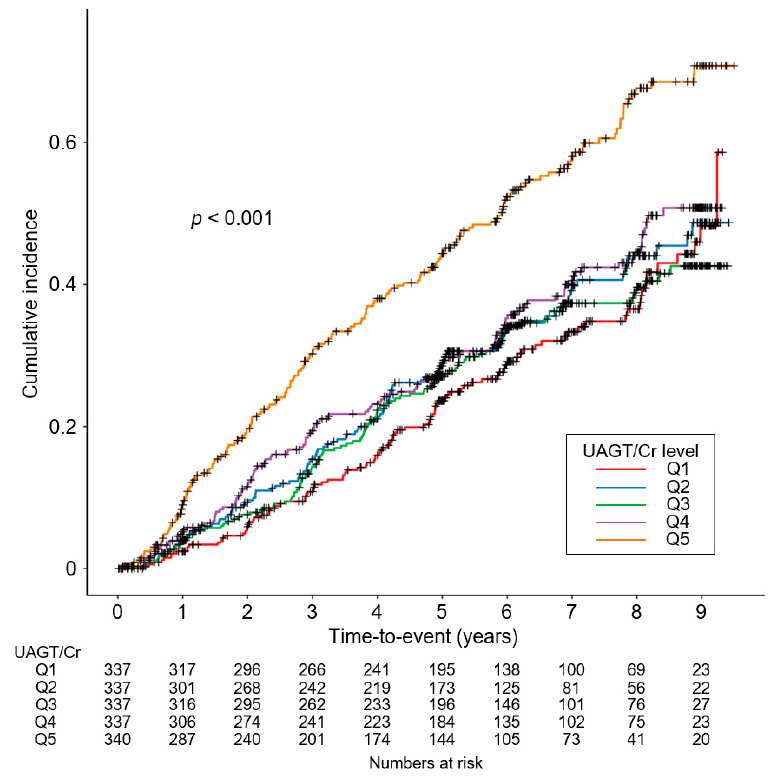
Figure 2. Kaplan–Meier survival curve for cumulative incidence of composite renal events by UAGT/Cr. p value by log-rank test. Abbreviations: Q1, 1st quintile; Q2, 2nd quintile; Q3, 3rd quintile; Q4, 4th quintile; Q5, 5th quintile; UAGT/Cr, urinary angiotensinogen-to-creatinine ratio. Table 2. HRs for composite renal event by UAGT/Cr level.